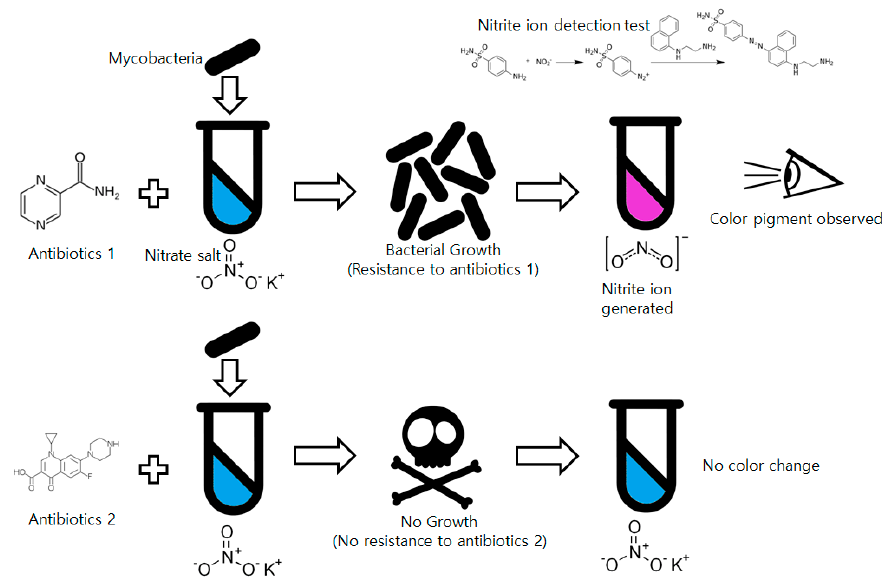
Figure 1. Process of the drug susceptibility test of mycobacteria using the nitrate reductase assay.